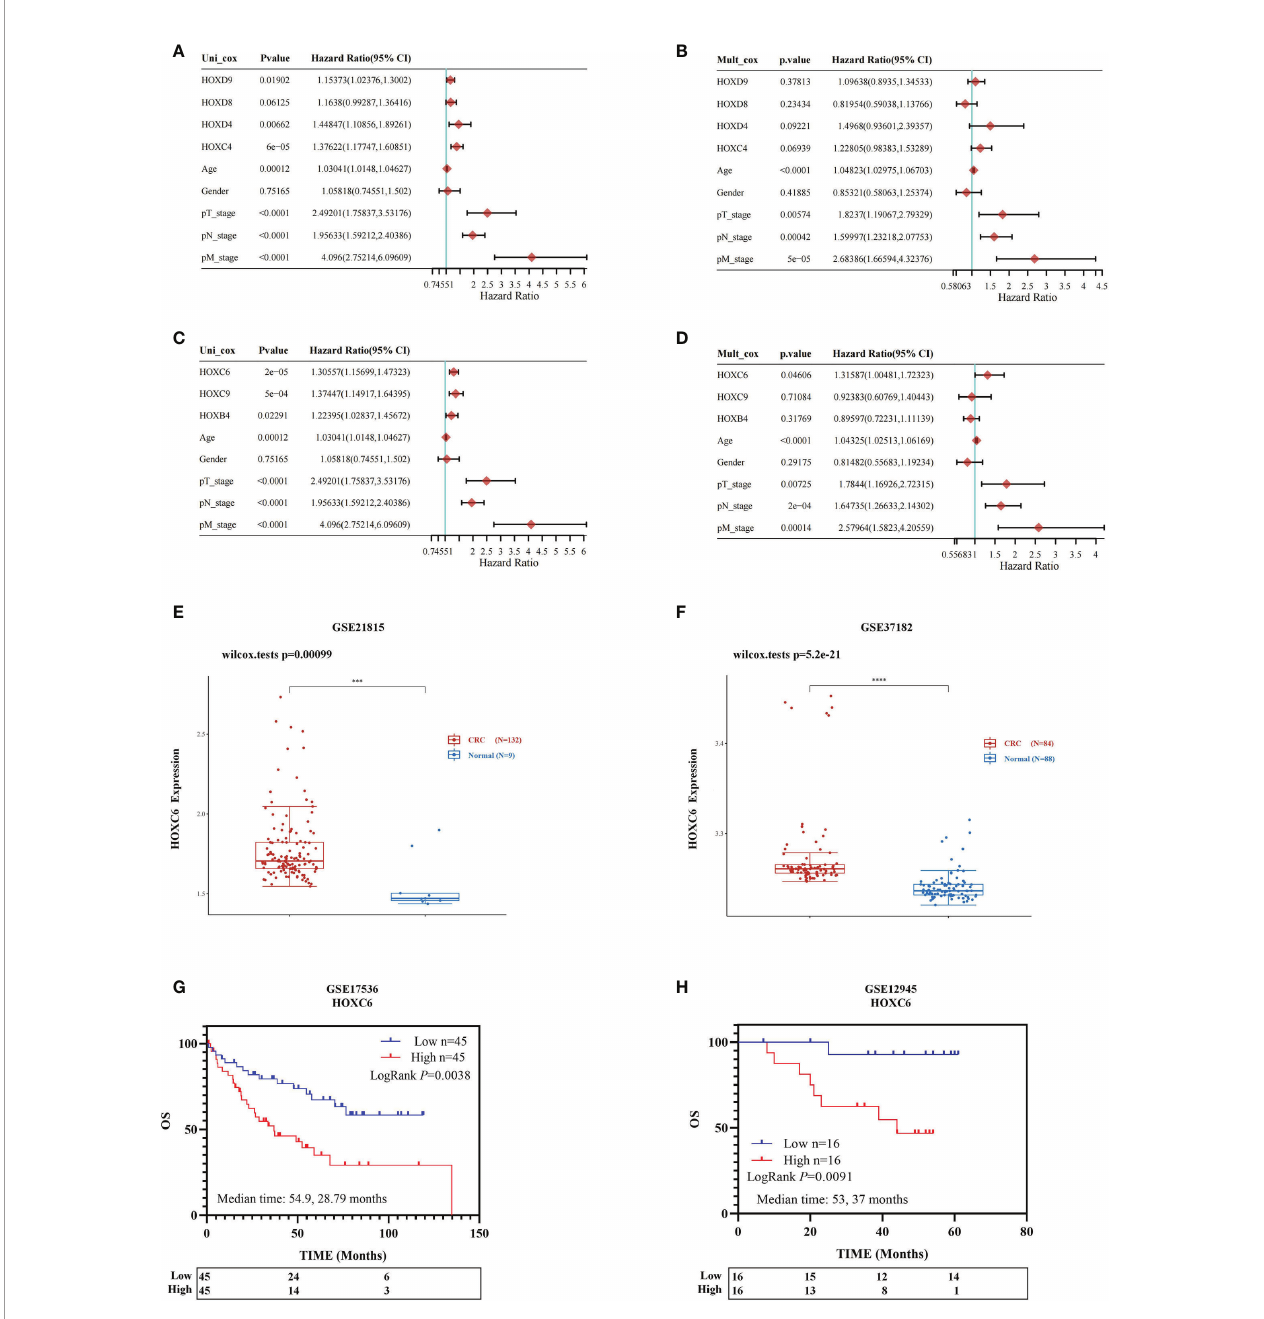
FIGURE 2 | Prognostic analysis of three signi fi cantly differentially expressed genes and identi fi cation of HOXC6 upregulation and prognostic value. Univariable and multivariable Cox regression analysis for the signi fi cantly downregulated genes (A, B) . (A) Univariable Cox regression analysis revealed that upregulation of HOXC4, HOXD4 and HOXD9 contributed to poor OS. (B) Multivariable Cox regression analysis revealed no signi fi cant results for HOXC4, HOXD4, HOXD8 and HOXD9. Univariable and multivariable Cox regression analysis for the signi fi cantly upregulated genes (C, D) . (C) Univariable Cox regression analysis revealed that upregulation of HOXB4, HOXC6, and HOXC9 contributed to poor OS. (D) Multivariable Cox regression analysis revealed that upregulation of HOXC6 contributed most to poor OS among HOXB4 and HOXC9. (E) The GSE21815 dataset con fi rmed that HOXC6 was signi fi cantly upregulated in CRC compared to normal colon tissue. (F) The GSE37182 dataset con fi rmed that HOXC6 was signi fi cantly upregulated in CRC compared to normal colon tissue. (G) . GSE17536 dataset con fi rmed that upregulation of HOXC6 was signi fi cantly associated with poor OS ( P =0.0038, median follow-up time for high and low expression groups: 54.9 and 28.79 months). (H) The GSE12945 dataset con fi rmed that upregulation of HOXC6 was signi fi cantly associated with poor OS ( P =0.0091, median follow-up time for high and low expression groups: 53 and 37 months). *** P <